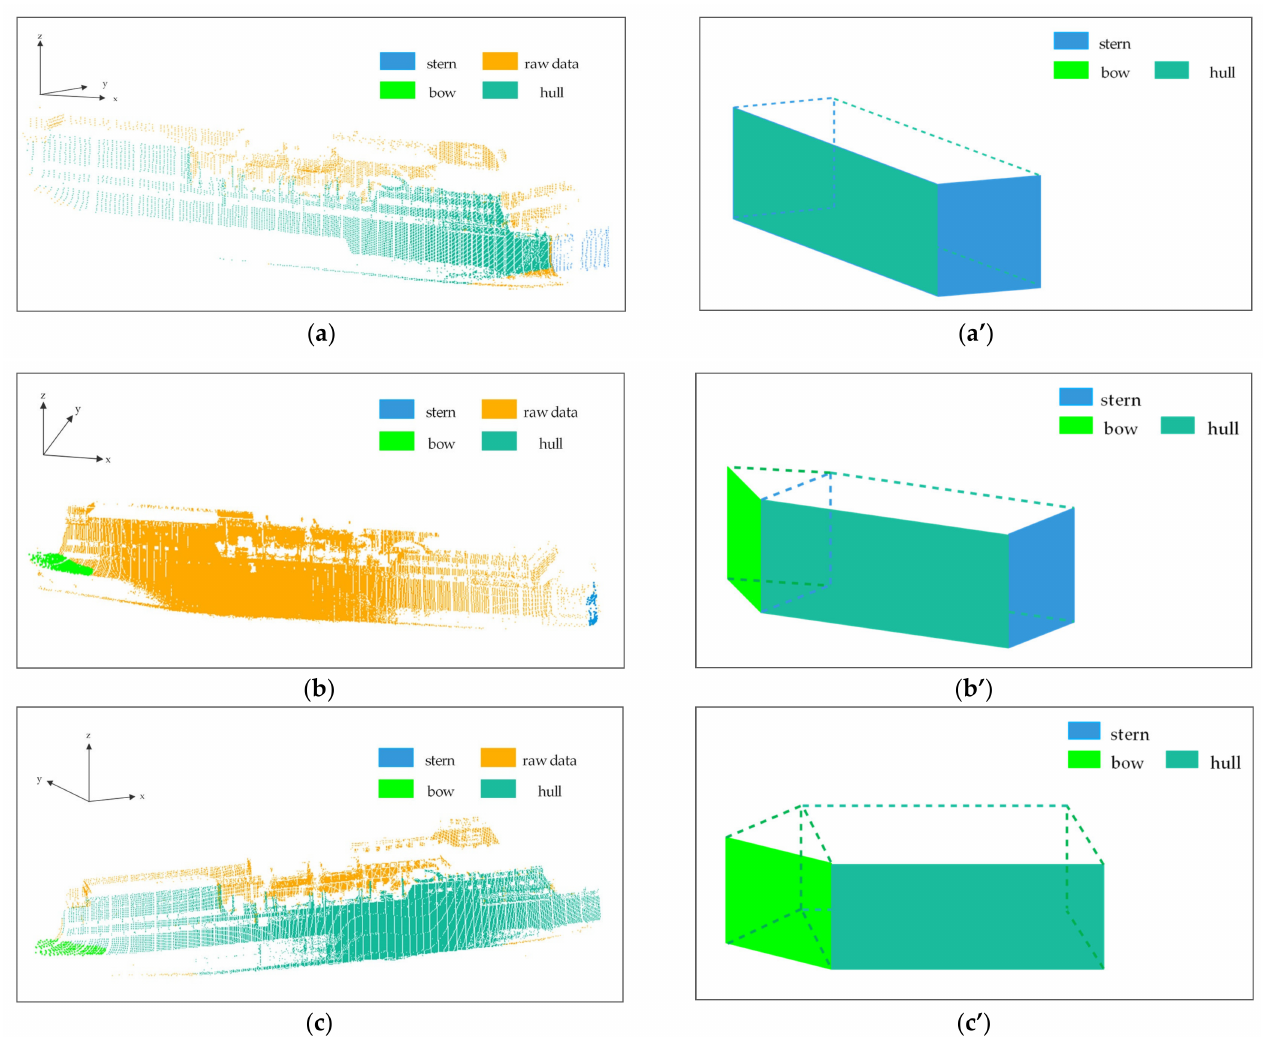
Figure 14. Bow and stern recognition: ( a ) the stern recognition; ( a ’) the corresponding view to ( a ); ( b ) the bow and stern recognition; ( b ’) the corresponding view to ( b ); ( c ) the bow recognition; ( c’ ) the corresponding view to ( c